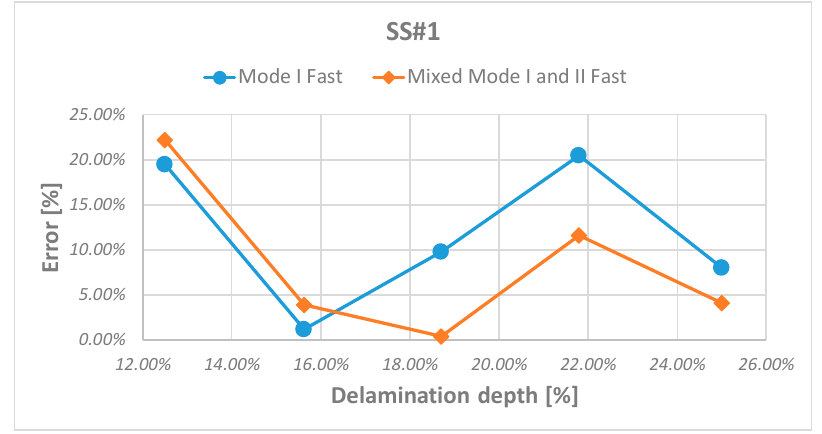
Figure 15. Error of critical load evaluation versus depth for SS#1 damage configuration.